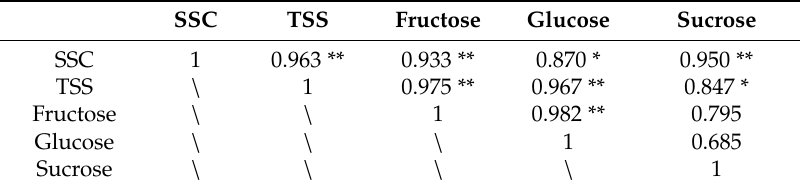
Table 2. Pearson (cid:48) s linear correlation coe ffi cients among SS and soluble sugars for 150 days at 0 ◦ C. SSC TSS